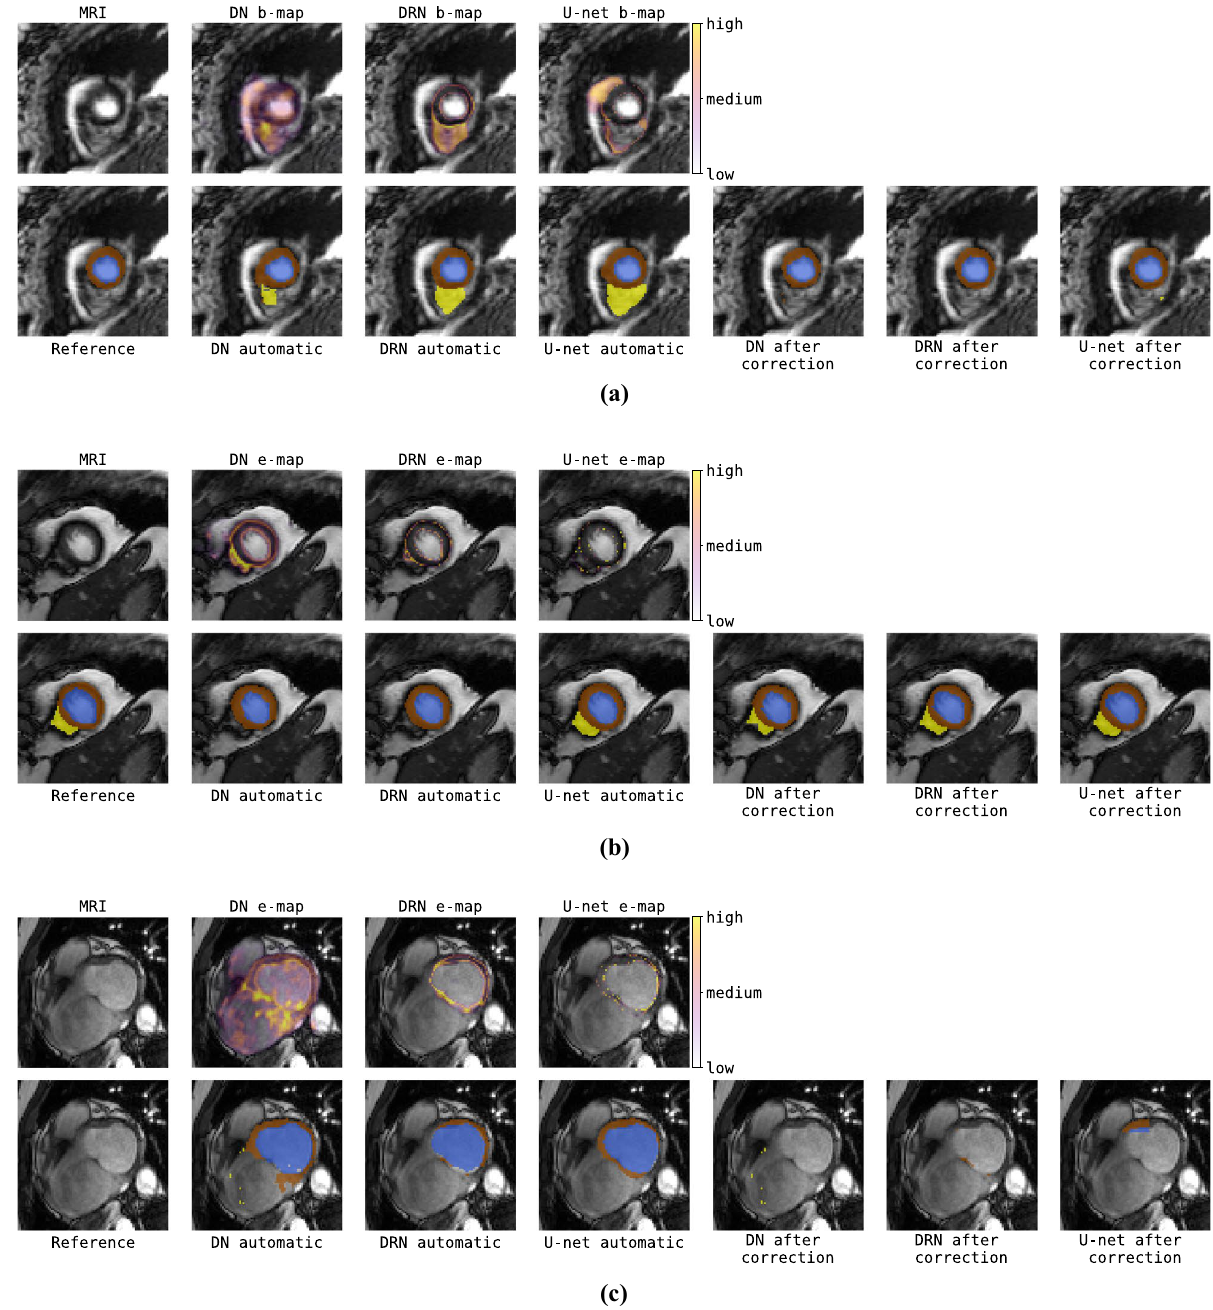
Figure 5. Three patients showing results of combined segmentation and detection approach consisting of segmentation followed by simulated manual correction of detected segmentation failures. First column shows MRI (top) and reference segmentation (bottom). Results for automatic segmentation and simulated manual correction respectively achieved by: Dilated Network (DN-Brier, 2nd and 5th columns); Dilated Residual Network (DRN-soft-Dice, 3rd and 6th columns); and U-net (soft-Dice, 4th and 7th